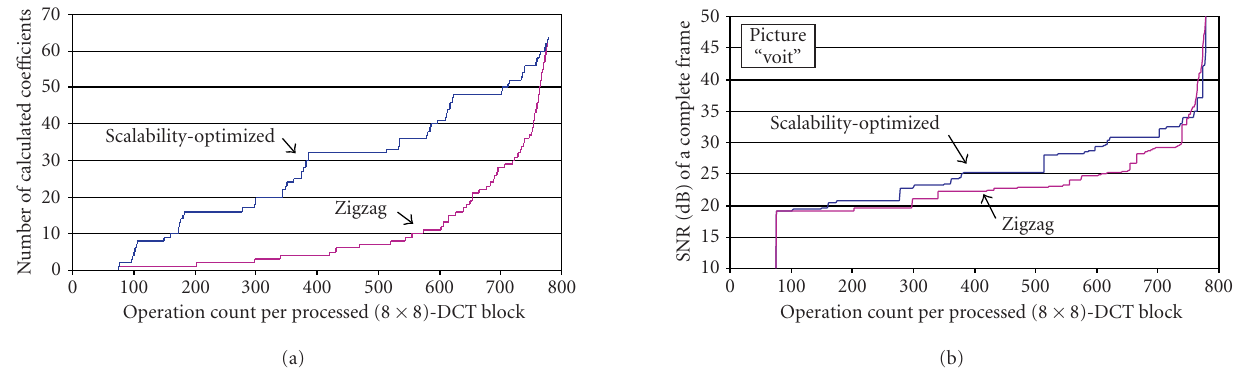
Figure 6: Comparison of the scalability-optimized computation order with the zigzag order. At limited computation resources, more DCT coe ffi cients are computed (a) and a higher PSNR is gained (b) with the scalability-optimized order than with the zigzag order.